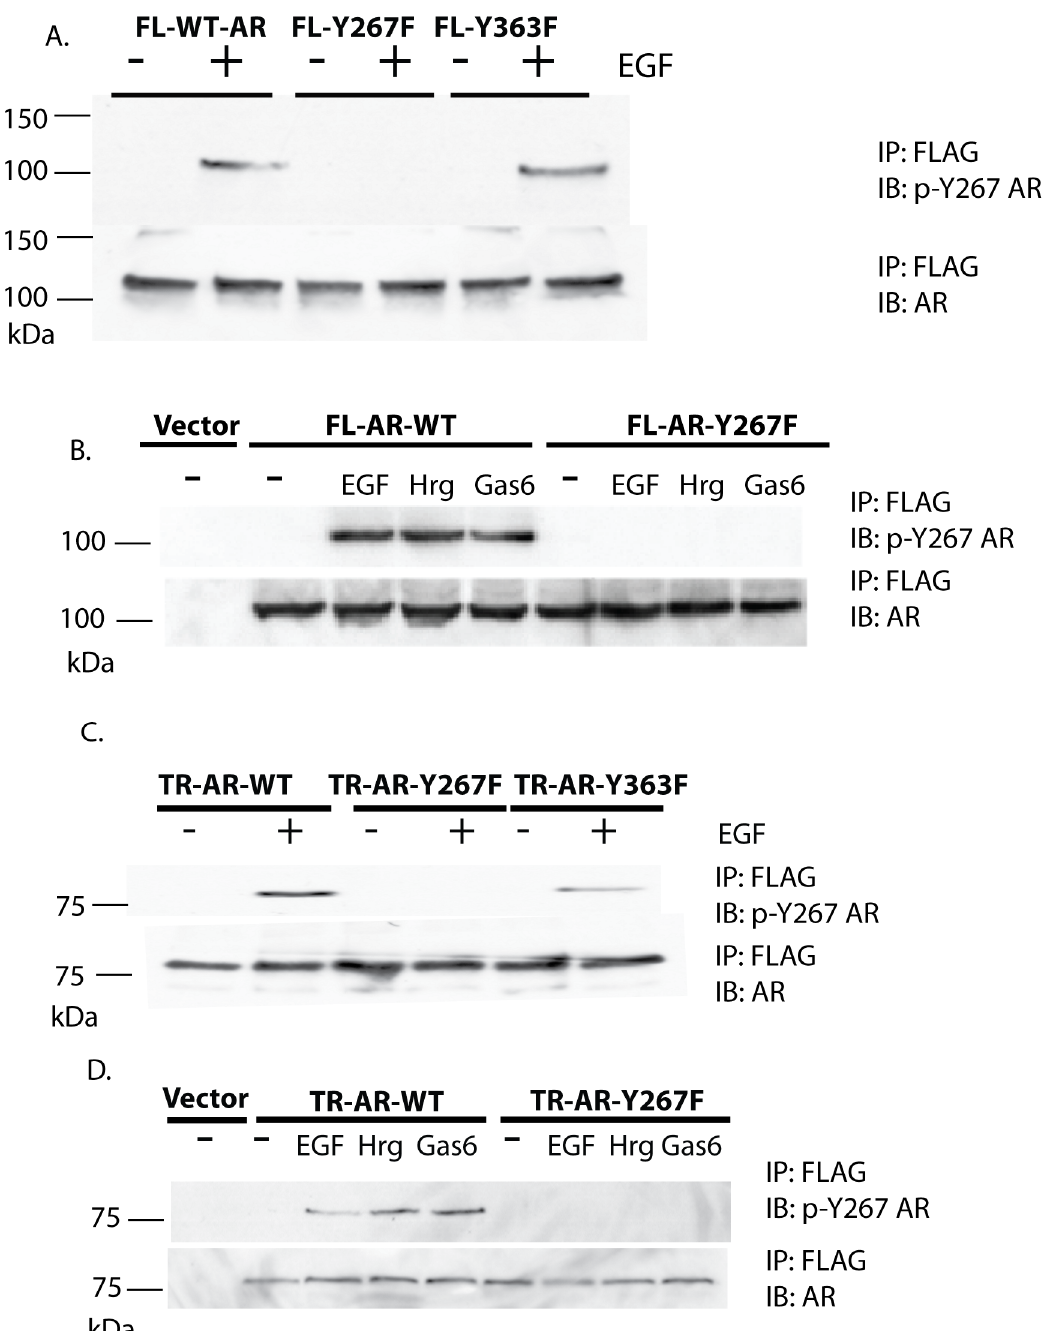
Fig 3. Exogenous AR stably expressed in LNCaP cells is phosphorylated at Tyr-267 after growth factor treatment. (A, B) LNCaP cells stably overexpressing full length AR were treated with EGF (100 ng/ml) or heregulin (10 ng/ml) or Gas6 (100 ng/ml) for 1 hr, as indicated. Cell lysates were subjected to immunoprecipitation with the FLAG antibody, followed by immunoblotting with the phospho-specific AR or total AR antibody. (C, D) LNCaP cells stably overexpressing truncated AR were treated with EGF (100 ng/ml) or heregulin (10 ng/ml) or Gas6 (100 ng/ml) for 1 hr, as indicated. Cell lysates were subjected to immunoprecipitation with the FLAG antibody, followed by immunoblotting with the phospho-specific AR or total AR antibody.